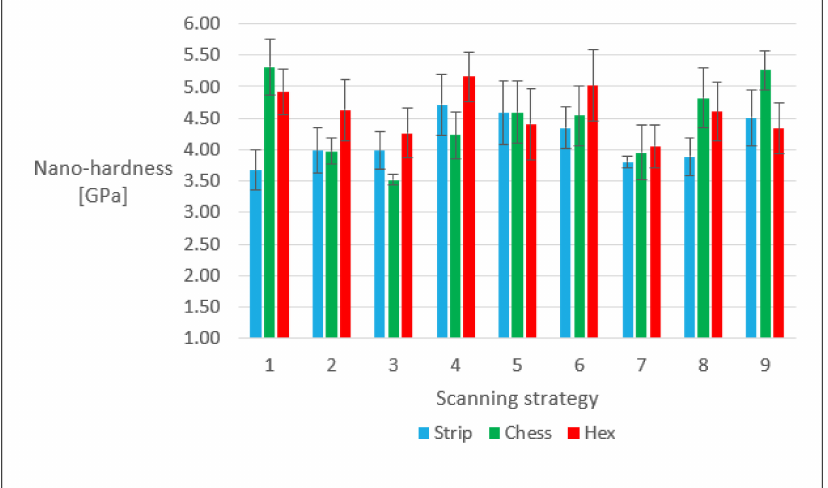
Figure 9. Nano-hardness (average values and standard deviation) of the as-built specimens belonging to different